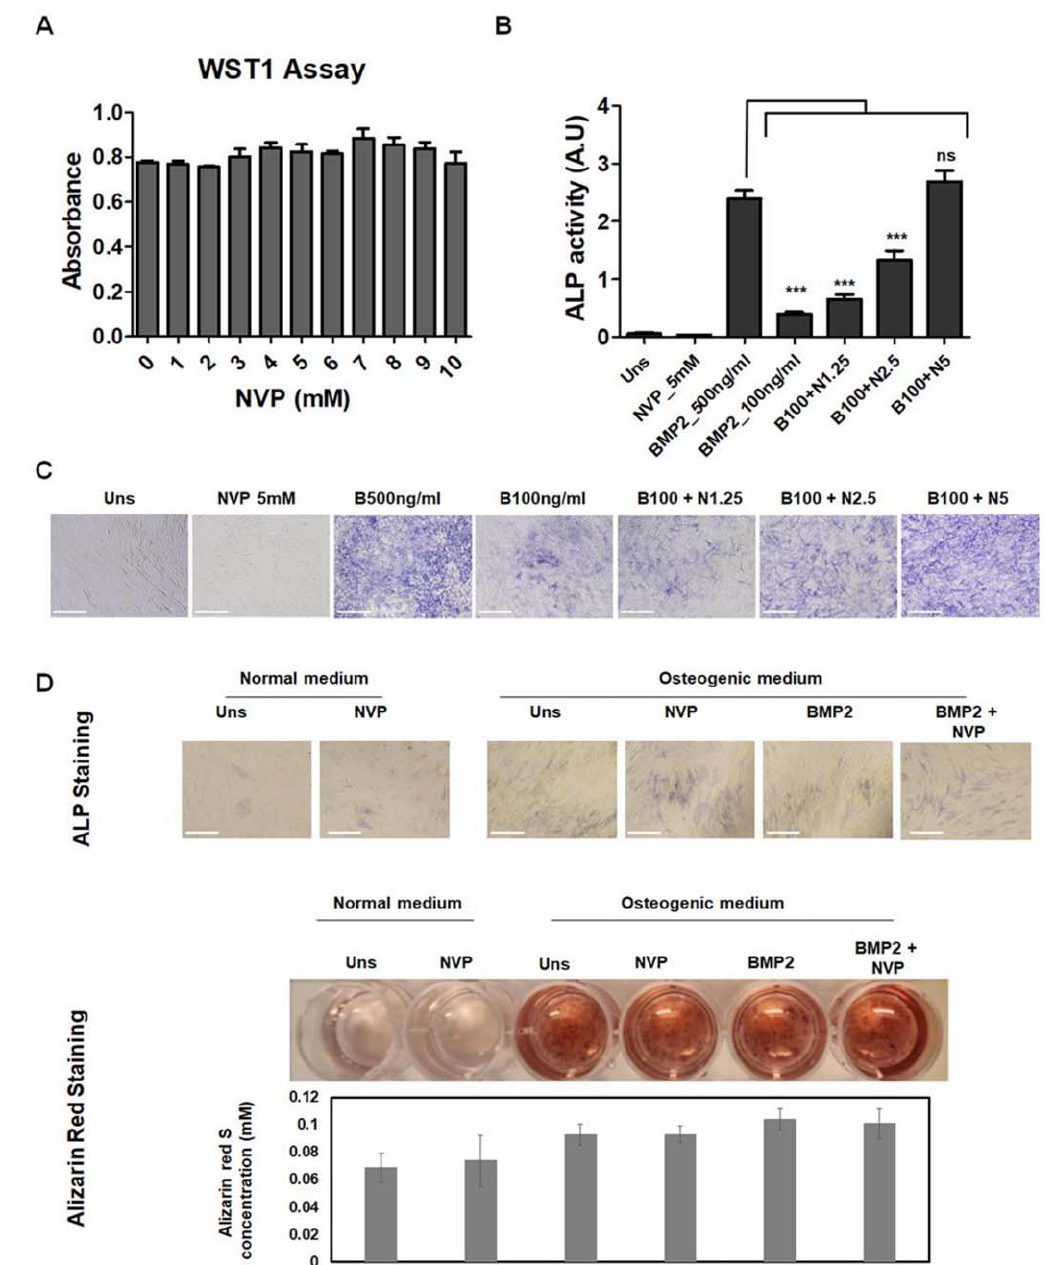
Figure 2. The effect of NVP on the viability and BMP2-induced osteoblast differentiation. ( A ) C2C12 cytotoxicity assay using the WST-1 reagent. The absorbance (450–600 nm) directly correlates to cell number. ( B , C ) Effects of NVP on BMP-induced Alkaline Phosphatase Activity (ALP) in C2C12 cell line. Cells were treated with BMP2 (500 or 100 ng/mL), or BMP2 and NVP (B+N) at the concentration indicated ranging from 1.25 to 5 mM. After 6 days, the cells were lysed to measure ALP activities ( B ) or fixed and stained for ALP ( C ) as described in Materials and Methods. Error bar indicates S.D. from triplicate samples. For BMP2 (500 ng/mL) vs. BMP2 (100 ng/mL) with or without NVP ***: p < 0.001. ( D ) Effects of NVP on ALP and calcium deposition in primary osteoblasts. Rabbit primary osteoblast were seeded in 24-well culture plates in normal medium (alpha-MEM, 10%FBS) or osteogenic medium ((alpha-MEM, 10%FBS, 50 µ g/mL ascorbic acid, 10 mM β -glycerophosphate, 10 nM dexamethasone) and treated with NVP (5 mM), BMP2 (100 ng/mL) or BMP2 in the presence of NVP (BMP+NVP). The medium was changed every 3 days and after 6 days (for ALP) or 14 days of cultures (for Alizarin Red), cells were fixed and staining for ALP and calcium deposition respectively. Scale bar: 50 µ